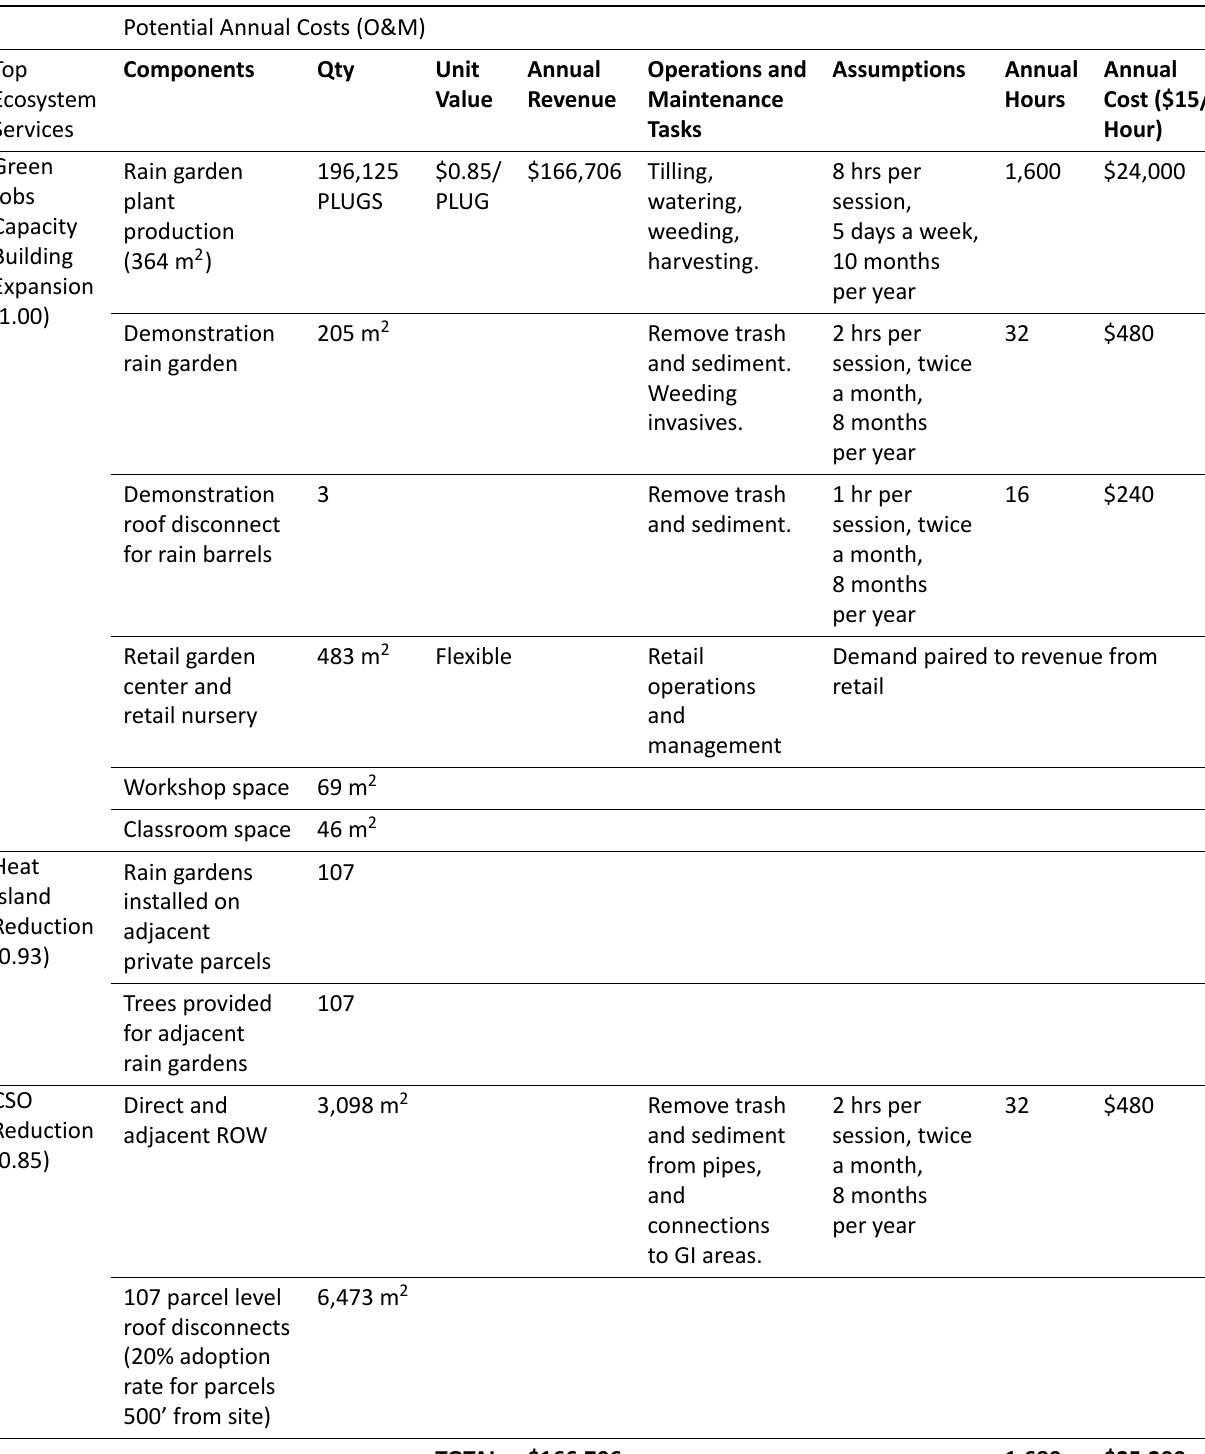
Table 4. Estimated revenue and costs associated with the Vine and Willard site conceptual